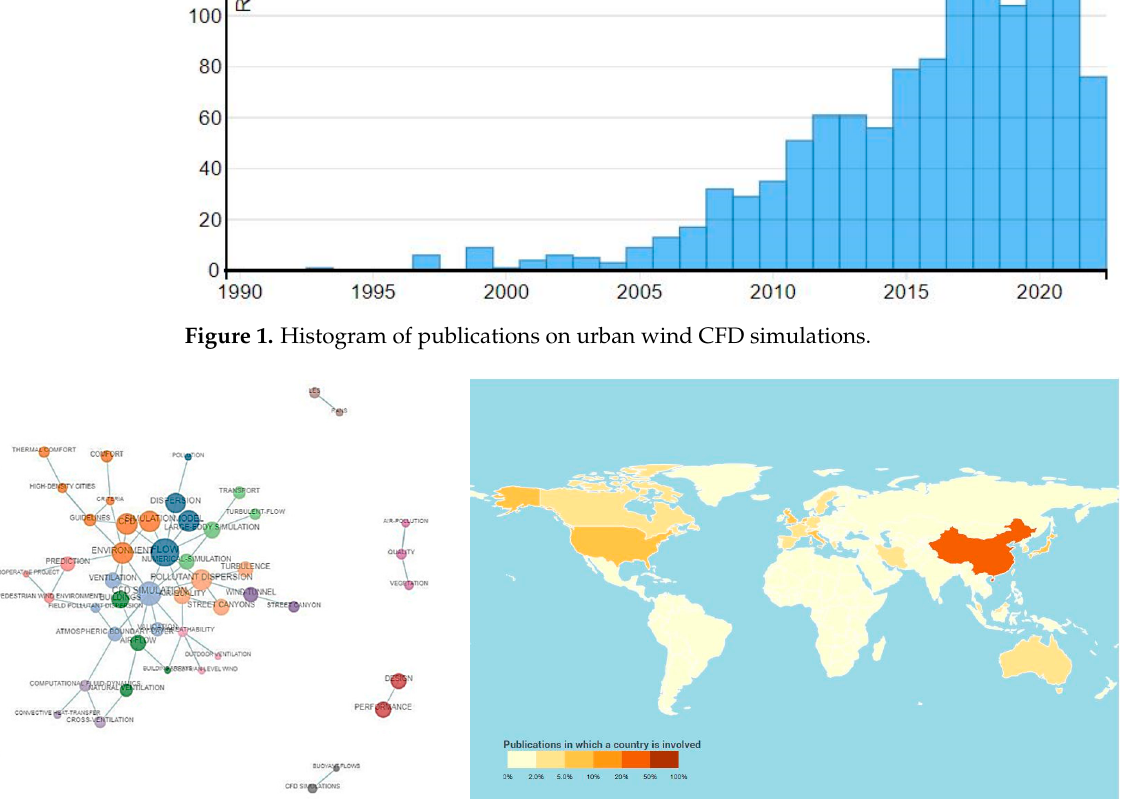
Figure 2. ( a ) Term map, ( b ) contribution of each country to the total number of papers.